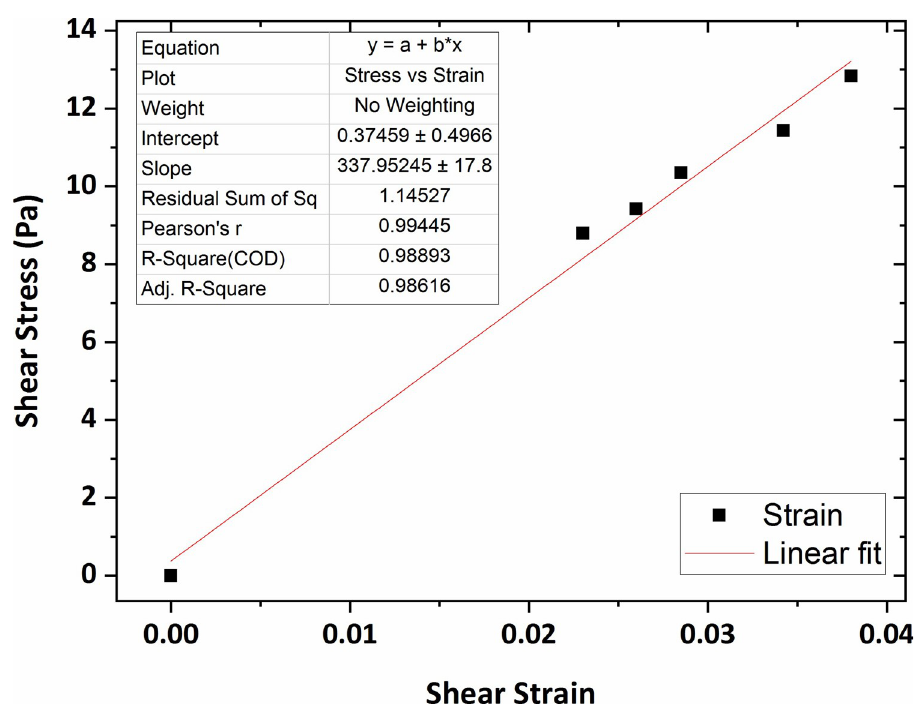
Fig 14. The graph of shear stress versus shear strain for the collagen gel of 0.3 wt % percent concentration.